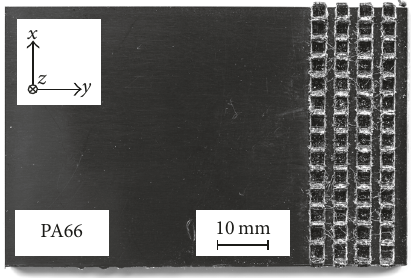
Figure 7: Photography of the prestructured joining partner A (PA66) with generated